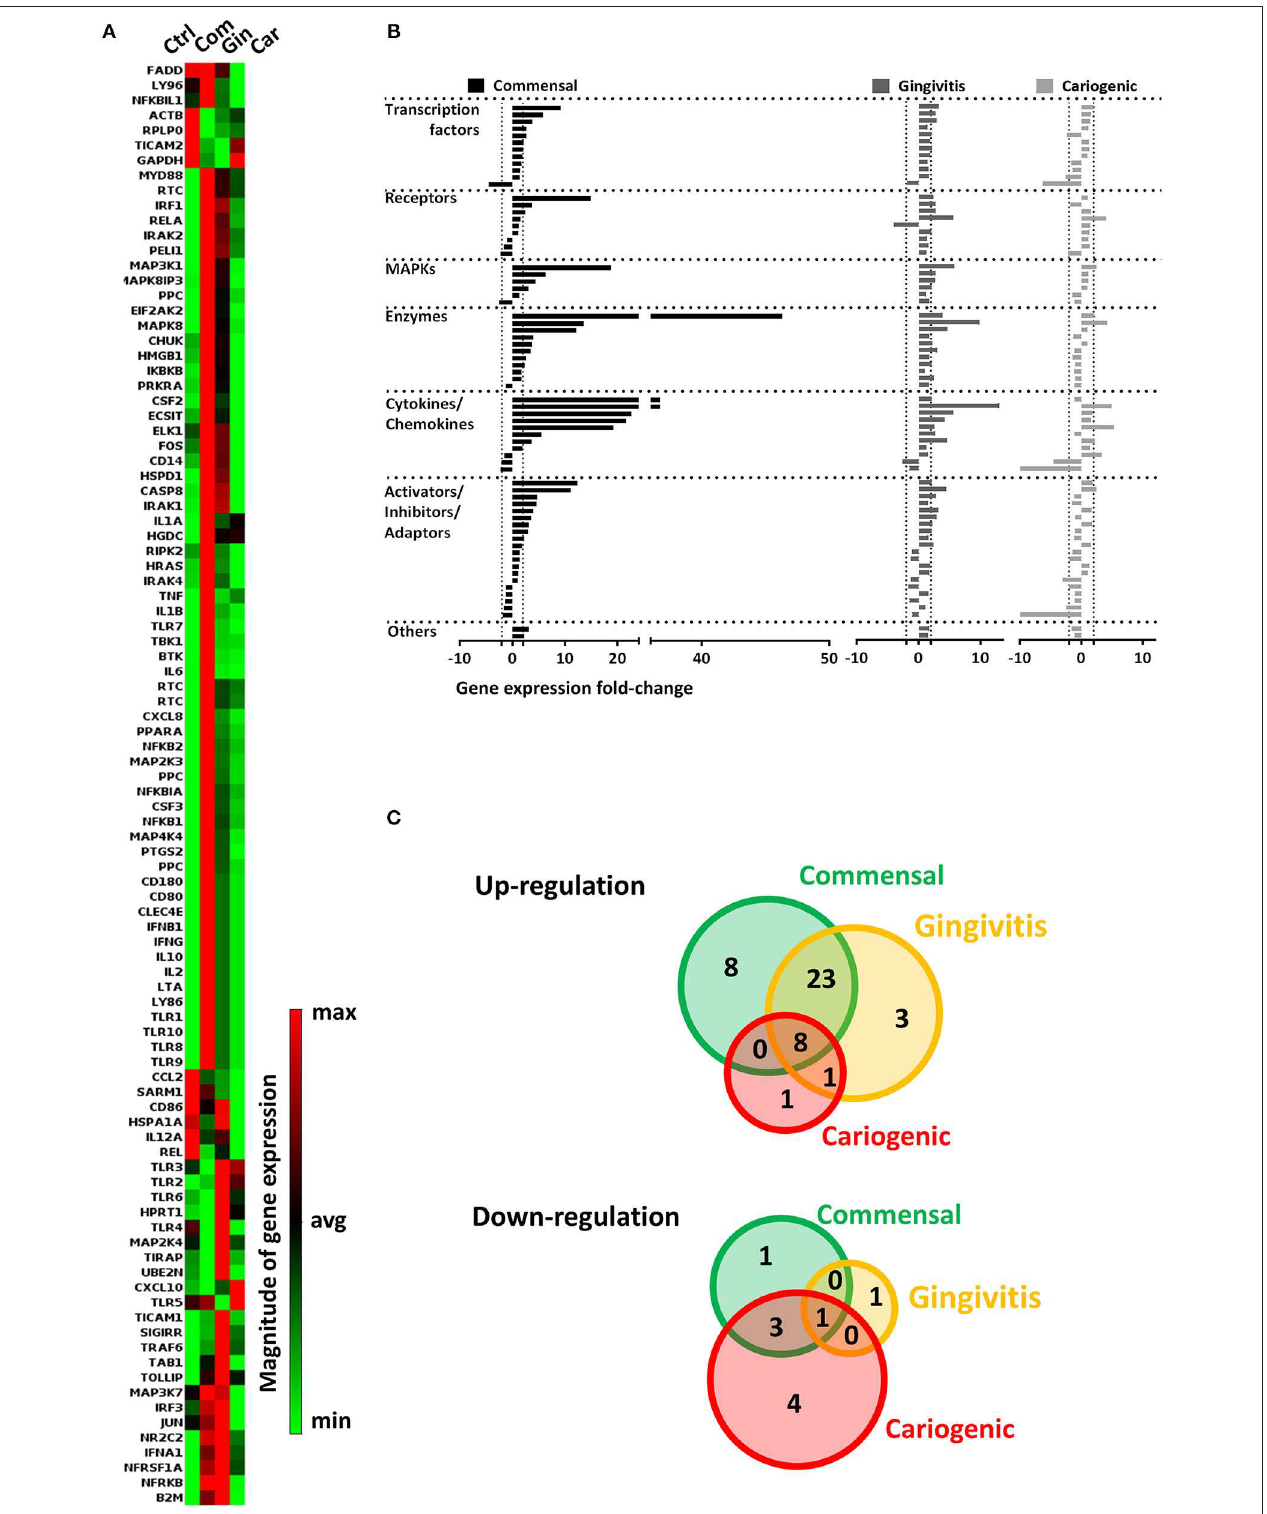
FIGURE 3 | Commensal and pathogenic biofilms differentially regulate the transcription of TLR signaling pathway in RHG. After 24h exposure, mRNA expressionof84keygenesinvolvedinTLRsignalingwasinvestigatedusingapreformattedRT ² ProfilerPCRarray.Datawhichwerenothomogenousineachofthethree